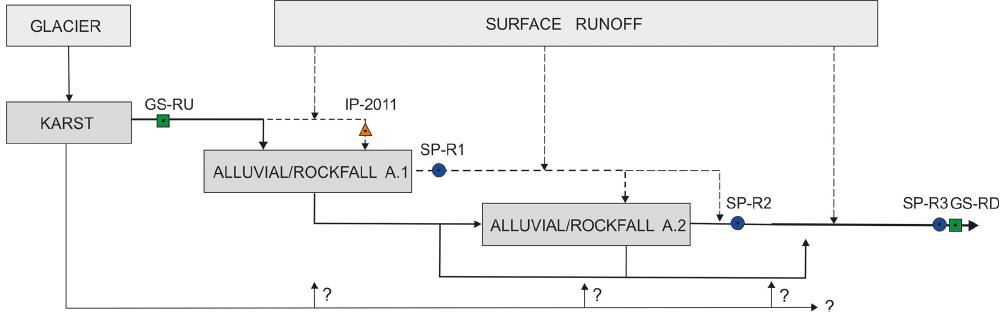
Figure 5. Conceptual model of the series of Alpine aquifers in the Reintal, which consists of a karst system and two alluvial/rockfall aquifer systems (i.e., alluvial/rockfall A.1 and A.2). Dashed lines indicate ephemeral discharge, solid lines indicate perennial